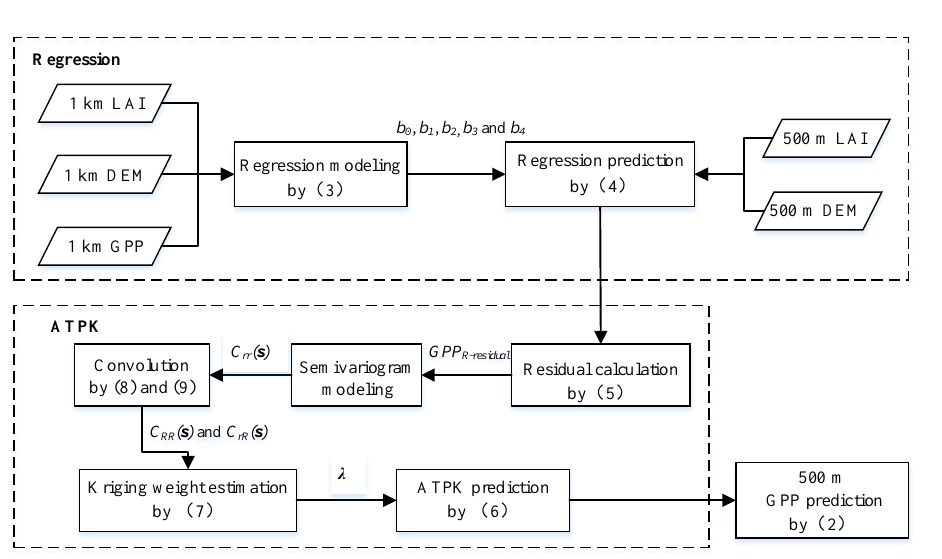
Figure 2. Flow chart of the proposed downscaling algorithm.